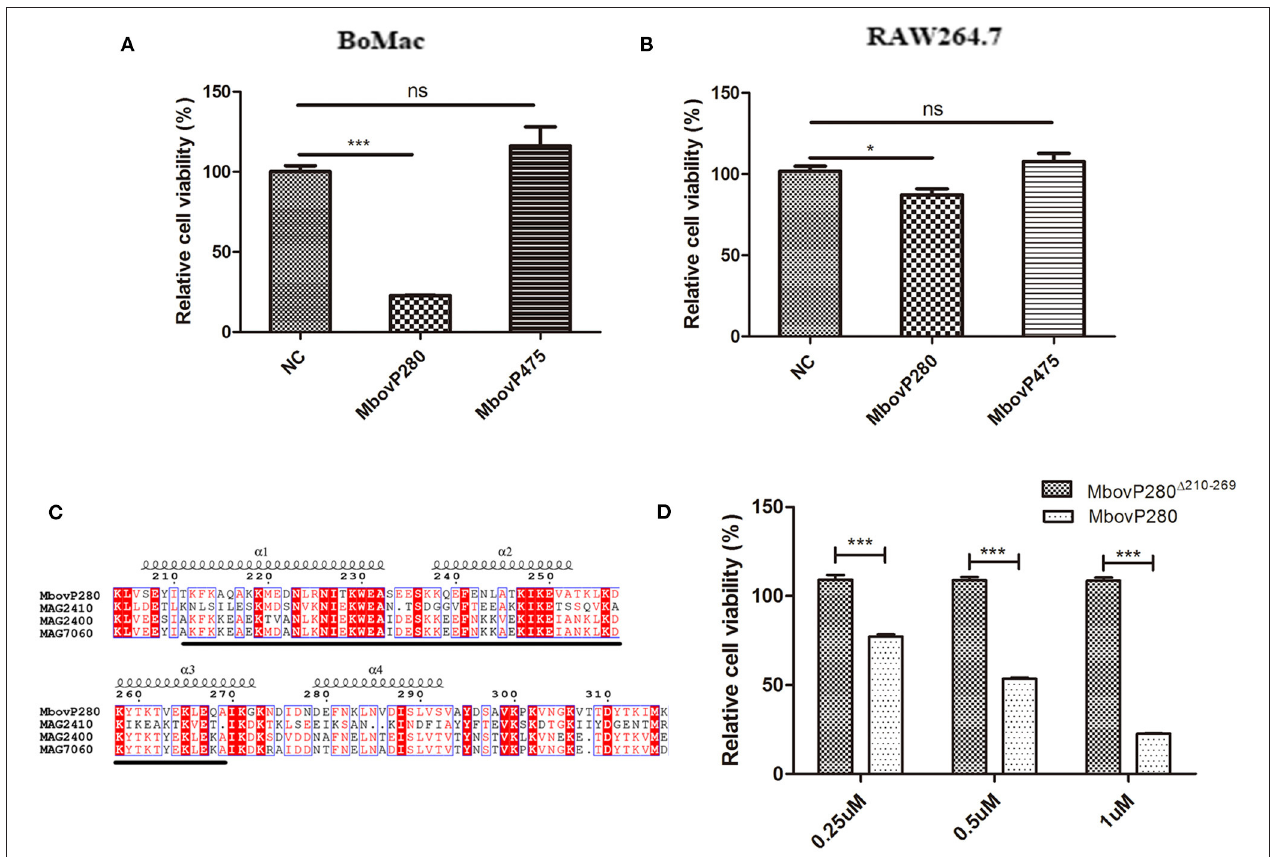
FIGURE 2 | Viability change of macrophages stimulated with the recombinant proteins of M.bovis . (A) BoMac cells (5 × 10 3 per well) or (B) RAW264.7 cells (1 × 10 4 ) were treated with either 1 µ M MbovP280 or 1 µ M MbovP475 for 24h, and then CCK-8 was added to each well to determine cell viability. Wells treated with PBS were used as the negative control (NC). (C) Proteins homologous to MbovP280 in Mycoplasma agalactiae were identified with MolliGen 3.0 (http://services.cbib.u- bordeaux.fr/molligen/). Amino acids 210–269 (black underline) were predicted to form a coiled-coil domain. A protein alignment was constructed with the ClustalW multiple sequence alignment programs (https://www.ebi.ac.uk/Tools/msa/clustalw2/) combined with ESPript 3.0 (http://espript.ibcp.fr/ESPript/ESPript/). (D) Relative cell viability of BoMac (5 × 10 3 cells per well) treated with MbovP280 or MbovP280 1 210 − 269 at concentrations of 0.25, 0.5, or 1 µ M for 24h was tested with a CCK-8 assay. * p < 0.05, *** p < 0.001 indicate statistically significant differences; while ns indicates no